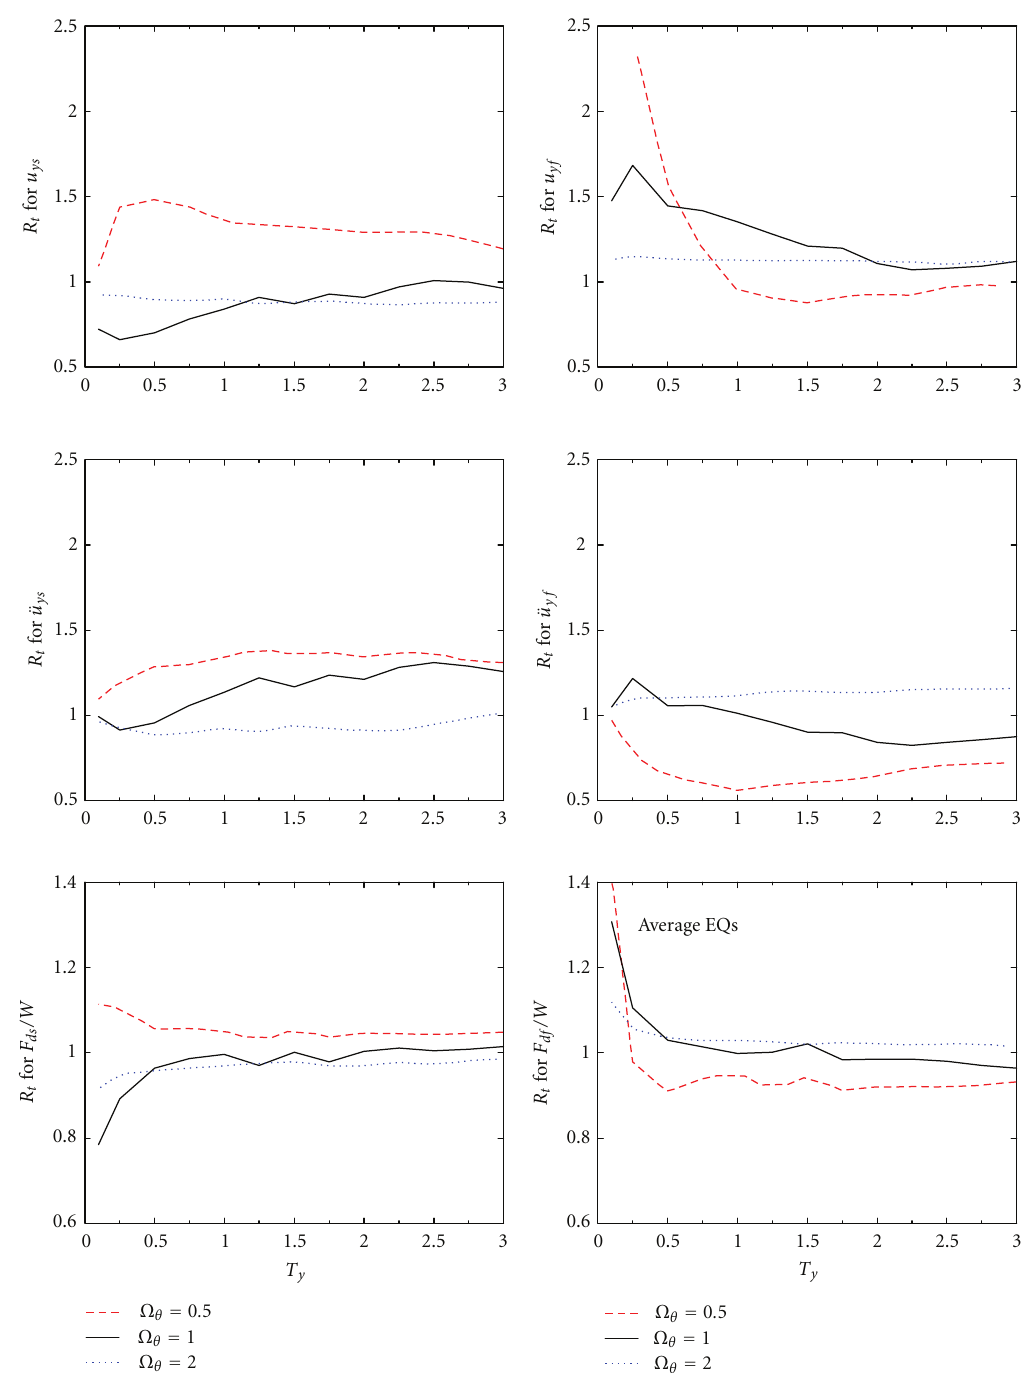
Figure 19: E ff ect of time period, T y on response ratio, R t for peak edge displacements and accelerations and RMS damper forces under average earthquakes ( e x / r = 0 .